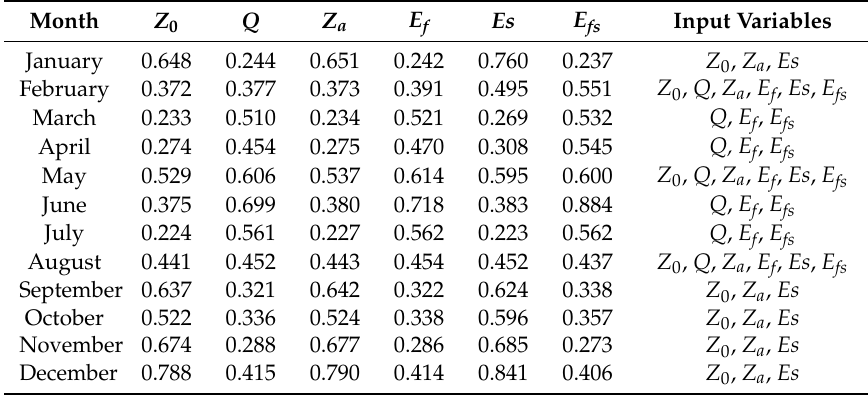
Table 5. The monthly input variables defined based on the optimal